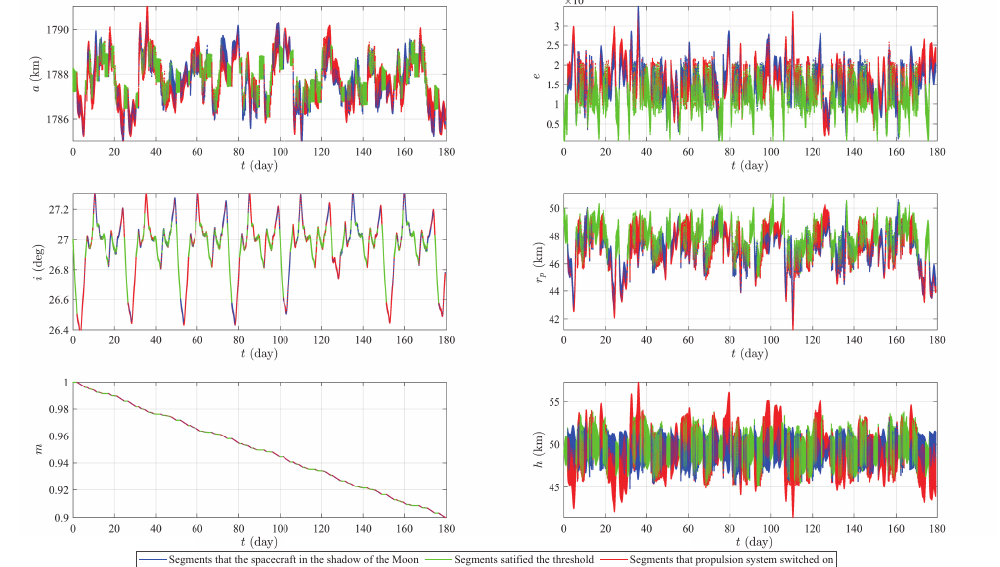
Figure 9. The plot of orbit elements verses life maintenance time with thrust (cid:107) T (cid:107) = 20 mN, Ω = 240 ◦ and i = 27 ◦